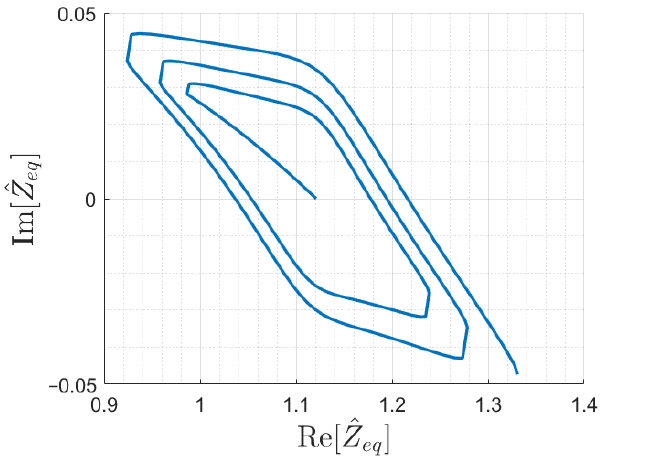
Figure 11. Input impedance trajectory as a function of the receiver position for the resonator array with six cells and series-compensated receiver, terminated with ˆ Z T 1 = 0.8 Ω